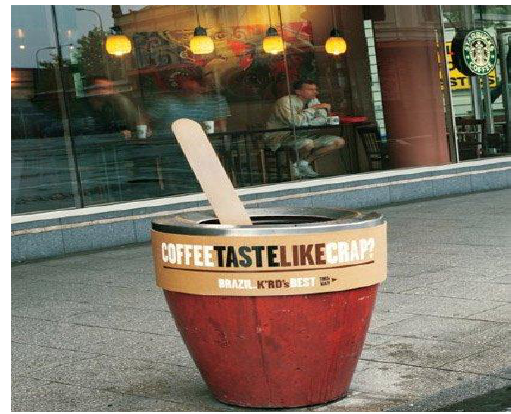
Figure 6. Brazil Coffee